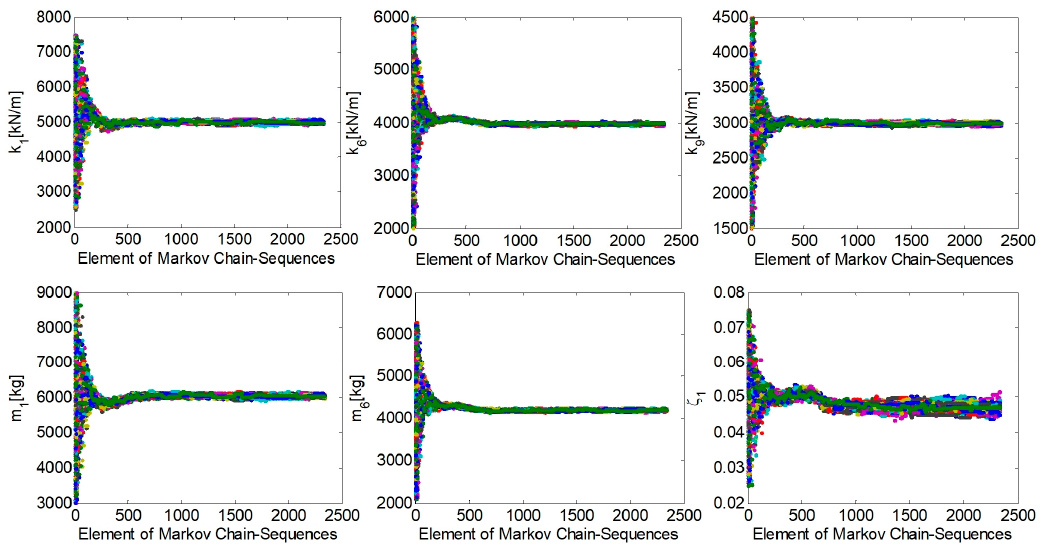
Figure 7. Generated samples for the six estimation parameters ( k 1 , k 6 , k 9 , m 1 , m 6 , ζ 1 ).